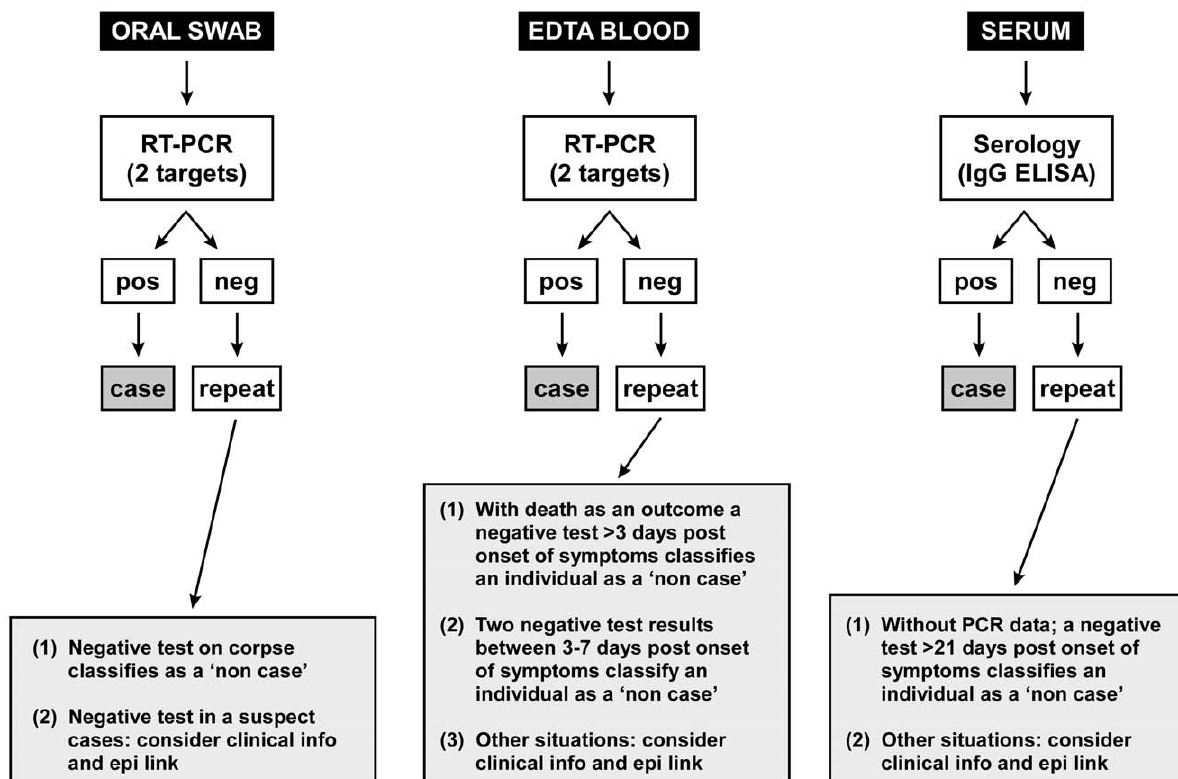
Figure 2. Diagnostic algorithm . Key: pos = positive; neg = negative.